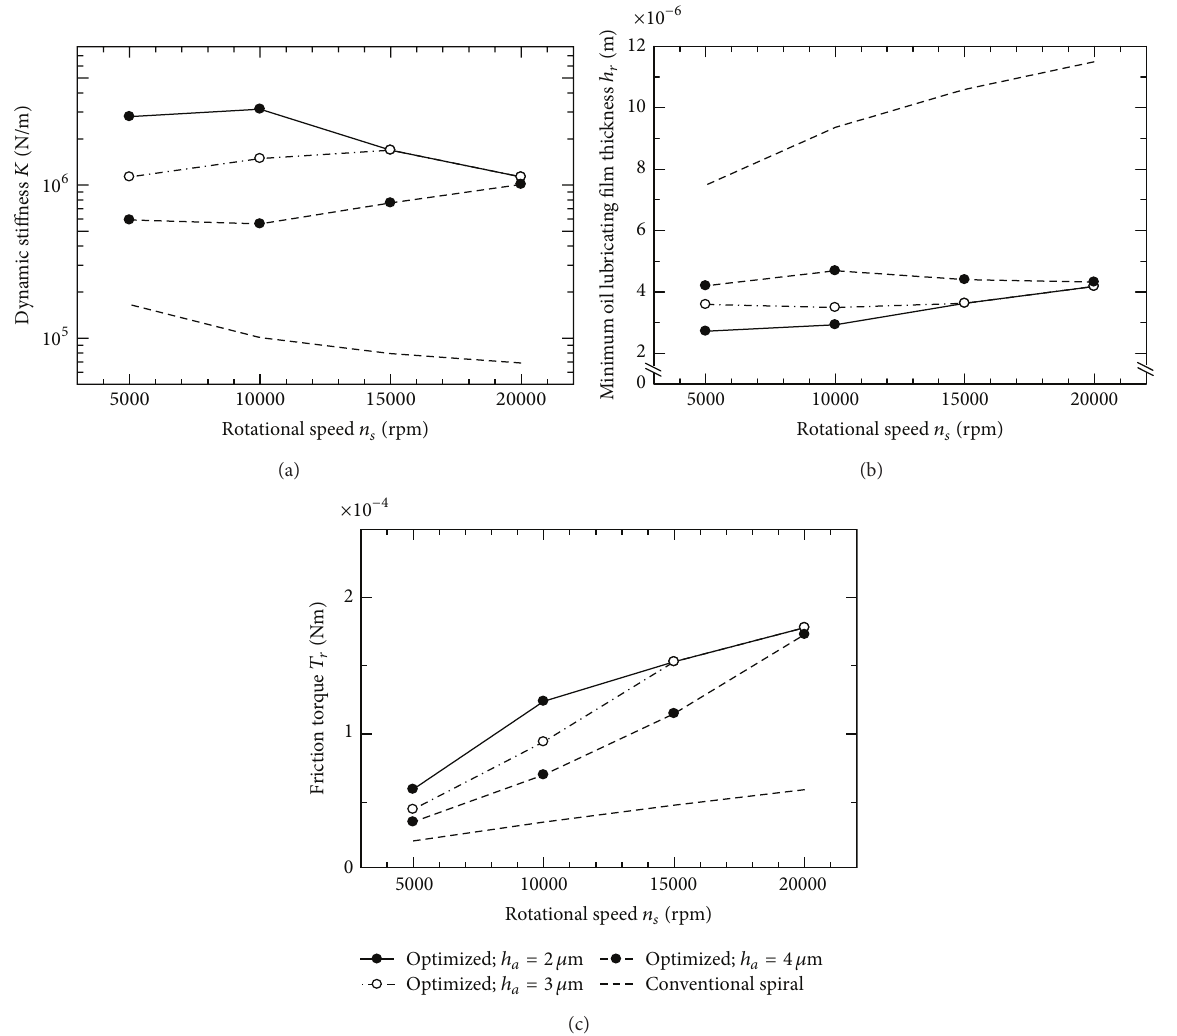
Figure 6: Bearing characteristics versus rotational speed; (a) dynamic stiffness 𝐾 , (b) minimum oil lubricating film thickness ℎ 𝑟 , (c) friction torque 𝑇 𝑟 .